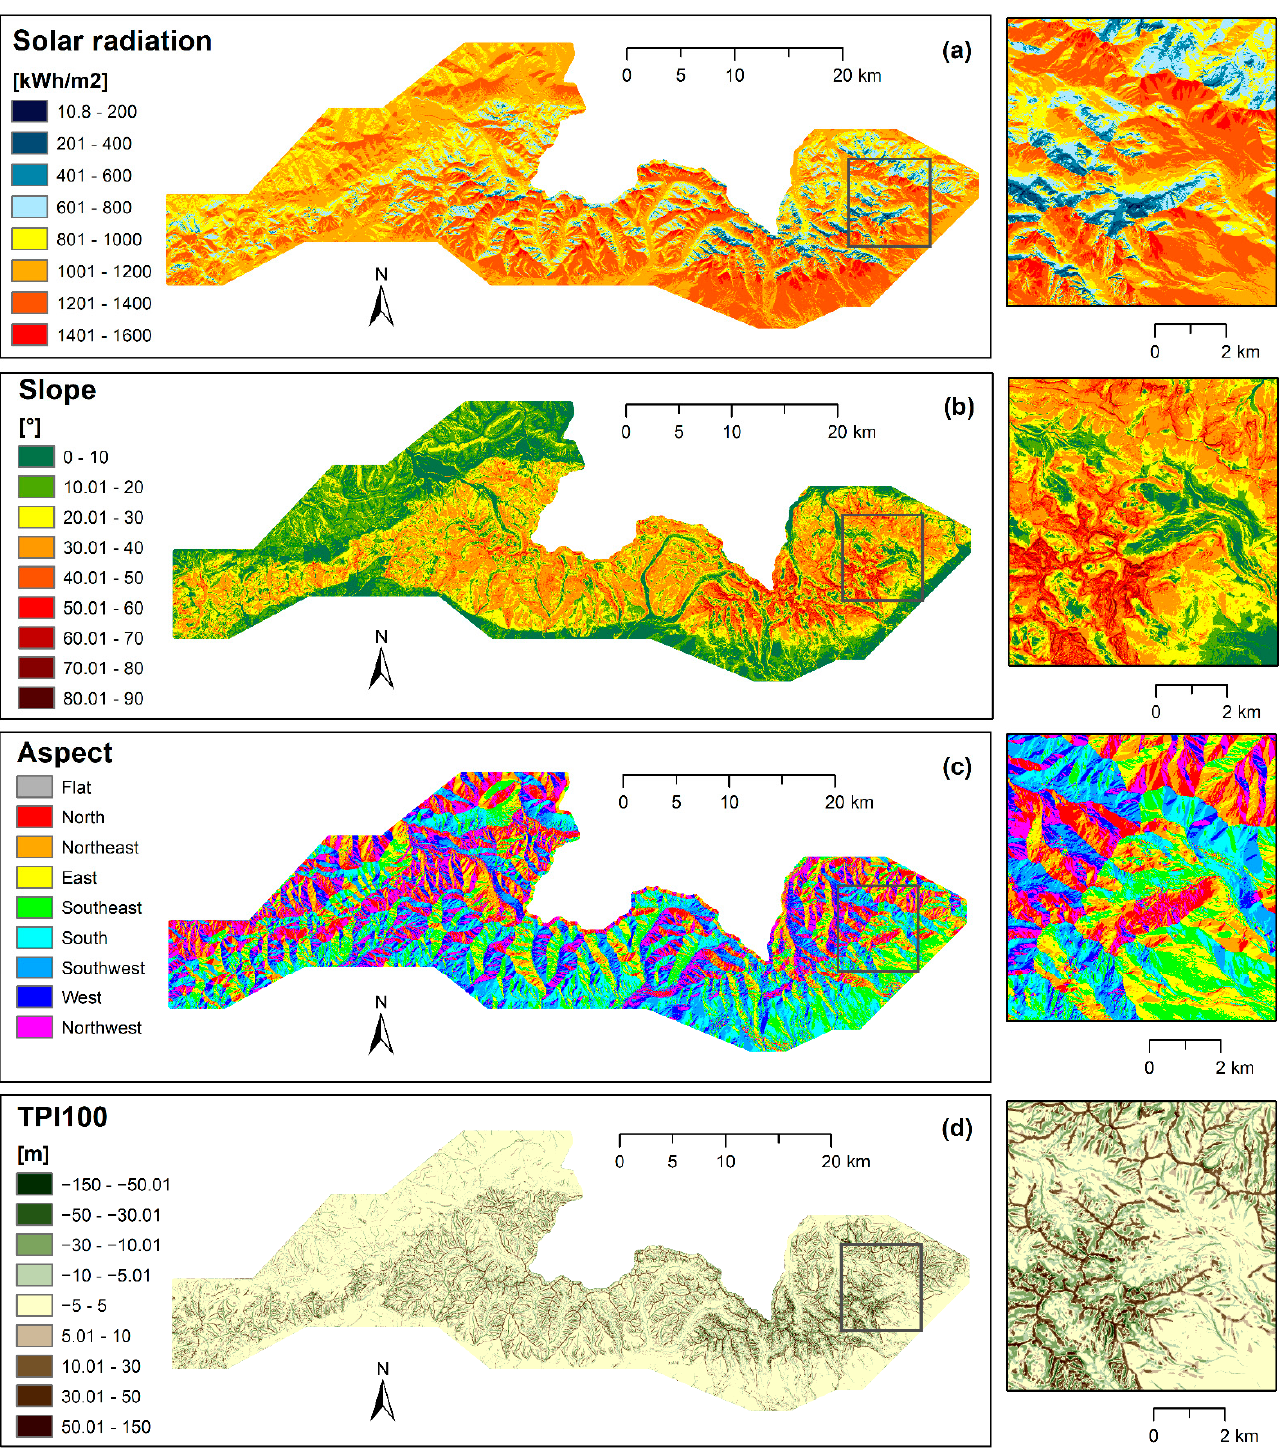
Figure 5. Potential solar radiation ( a ) and the basic terrain parameters in the Tatra Mountains: slope ( b ), aspect ( c ), and TPI100 ( d ) (calculated based on DTM 5.0 at a spatial resolution of 5 m). Data source: ÚGKK SR [45].